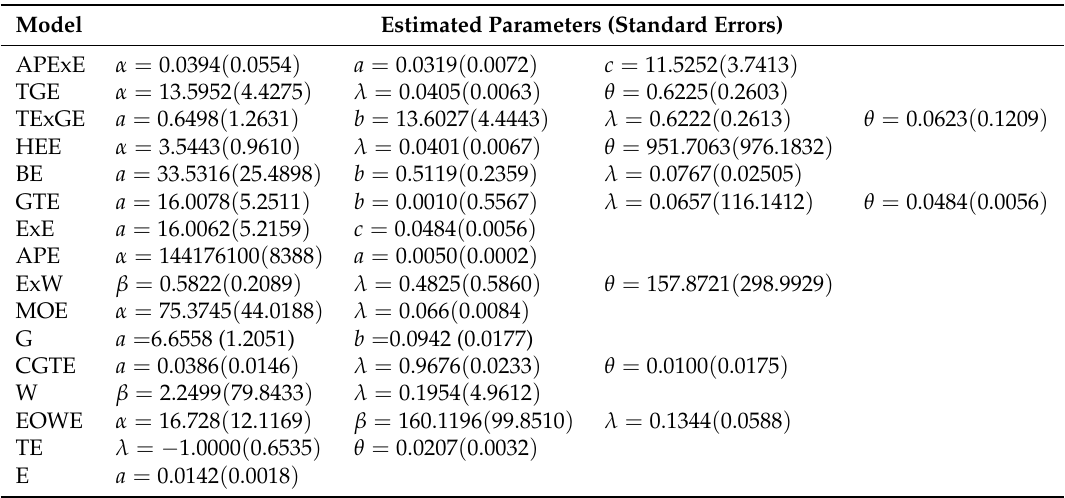
Table 4. Estimated parameters with their standard errors of the APExE model and other fitted models. Model